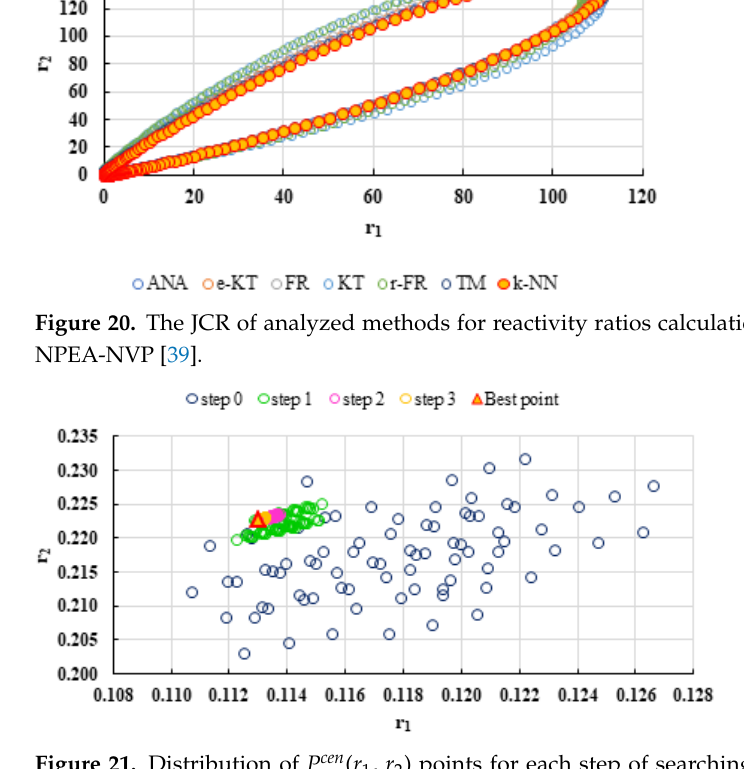
Figure 21. Distribution of P cen ( r 1 , r 2 ) points for each step of searching for the k-NN method for copolymerization of Is-GMA [40]. Table 22 . The reactivity ratios obtained for copolymerization of Is-GMA [40].